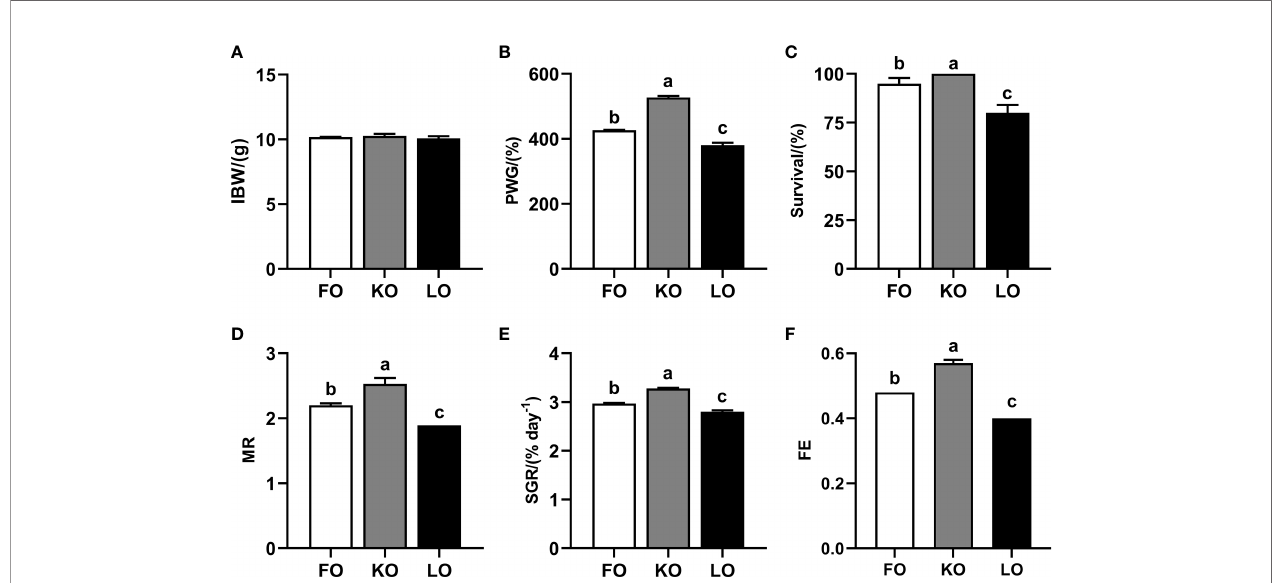
FIGURE 1 | Growth performance and feed utilization of swimming crab fed with different dietary lipid sources. Data are presented as the mean ± SE of four replicates (n = 4). Values in the same row with different superscripts are signi fi cantly different ( P < 0.05). (A) IBW, initial body weight; (B) PWG (percent weight gain, %) = 100 × [ fi nal body weight (g) − initial body weight (g)]/initial body weight (g); (C) Survival (%) = 100 × ( fi nal number of crab) / (initial number of crab); (D) MR (molting ratio) = 2 × the number of molting/( fi nal number of crab + initial number of crab); (E) SGR (speci fi c growth rate, % d-1) = 100 × [Ln ( fi nal body weight) −